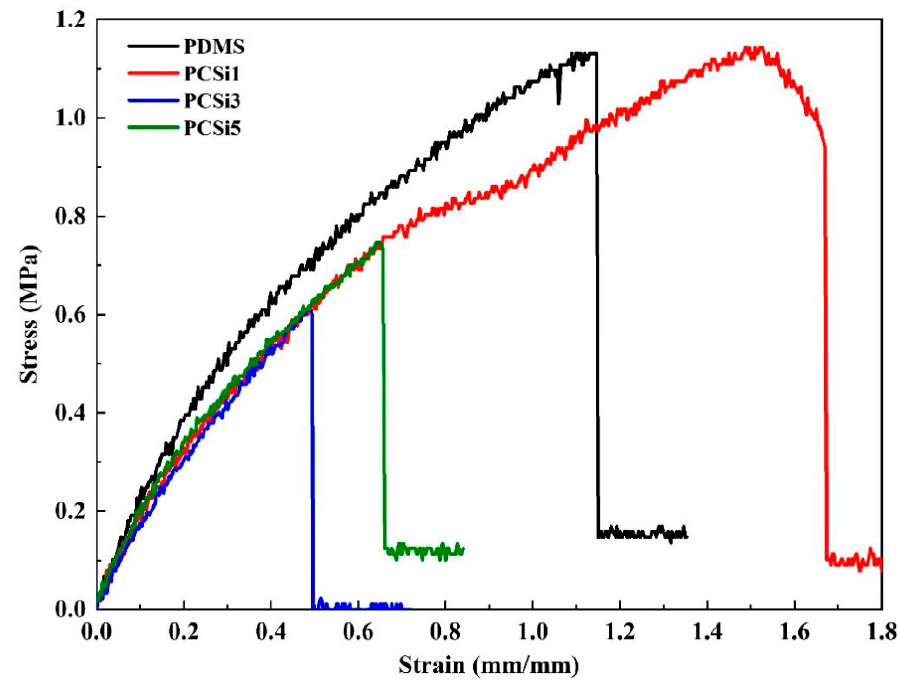
Figure 6. Stress–strain diagram for tensile test.